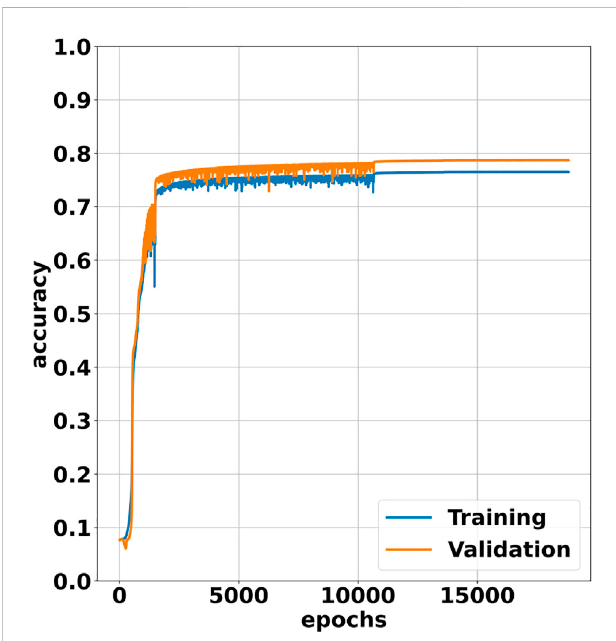
FIGURE 2 Training and validation plot for our NN over 18,000 epochs.